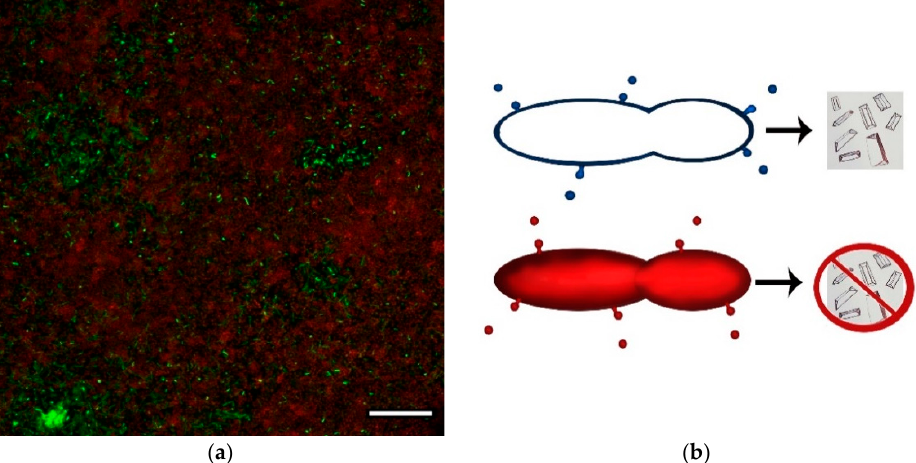
Figure 1. Confocal image of a mixed E. coli (red-fluorescing) and P. aeruginosa (green-fluorescing) biofilm grown in artificial urine ( a ) (Thornhill et al., unpublished). In ( b ), the outer membrane vesicles (OMVs) produced by one organism (blue outline) may promote struvite growth, whereas the OMVs having a different chemistry from another organism (red) may inhibit crystallization. Given the polymicrobial nature of most biofilms, bacterial interactions of cell surface structures including OMVs must be considered during biomineralization studies. Bar in ( a ) represents 30 µm. Micrograph in ( a ) is provided courtesy of S.G. Thornhill.